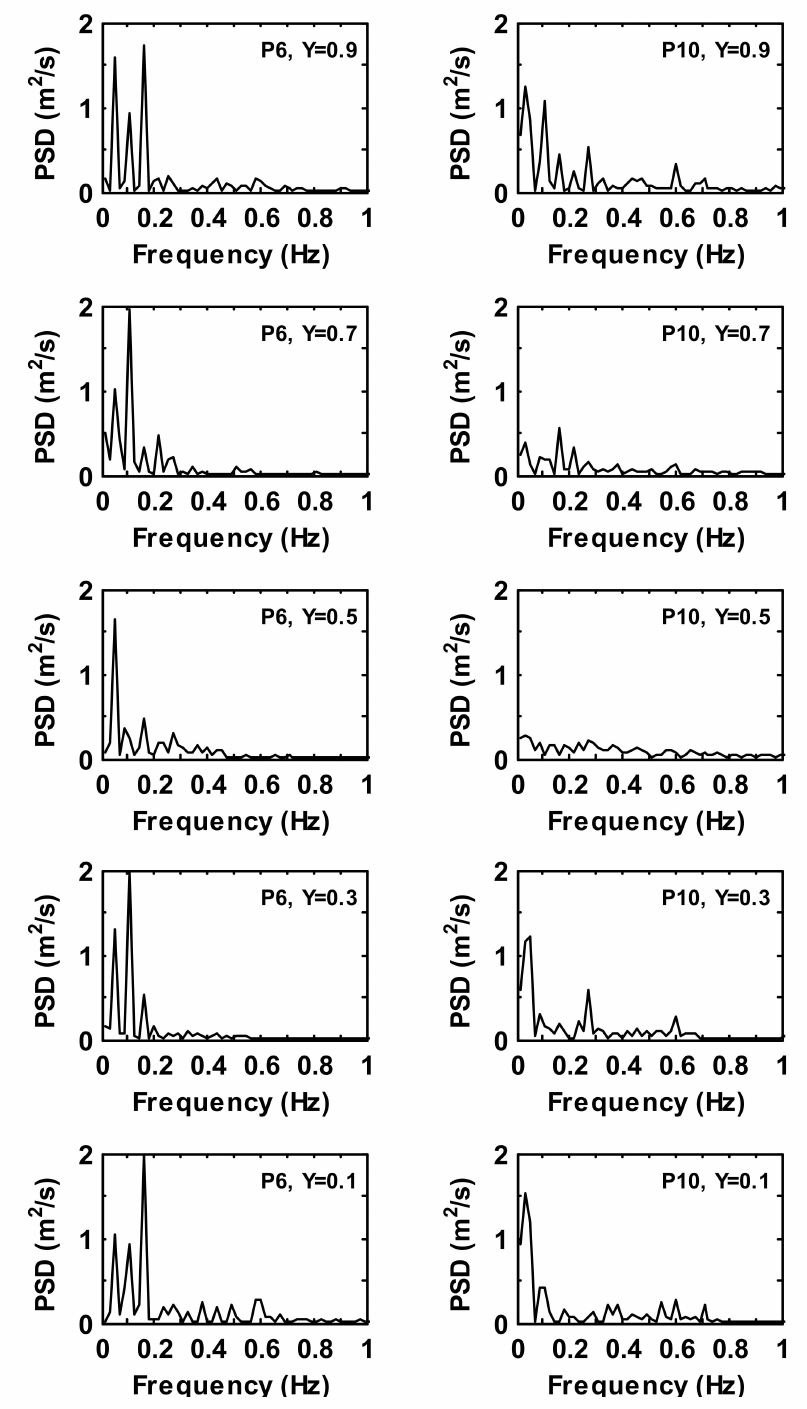
Figure 9. Power spectra density of the time history velocity magnitude fluctuations at monitoring locations P 6, P 10 for case